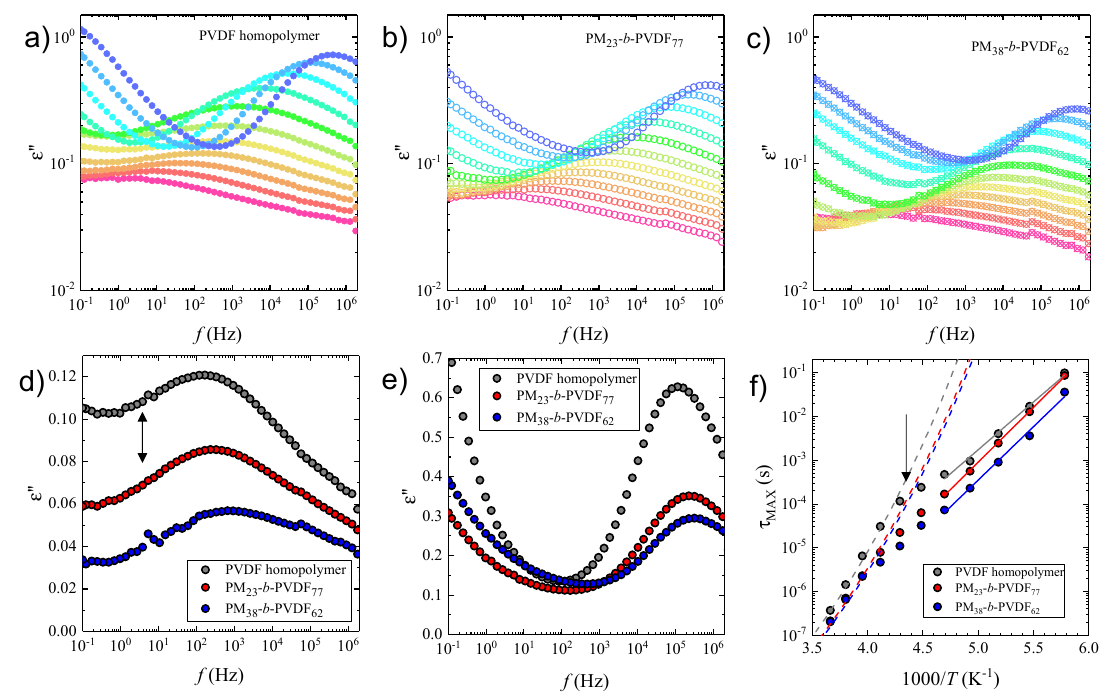
Figure 8. Dielectric spectra (imaginary part of the complex dielectric permittivity as a function of the frequency) for ( a ) PVDF homopolymer, ( b ) PM 23 - b -PVDF 77 , ( c ) PM 38 - b -PVDF 62 , as well as dielectric relaxations of the studied samples at ( d ) − 70 °C and ( e ) − 10 °C and ( f ) relaxation map of the studied samples.